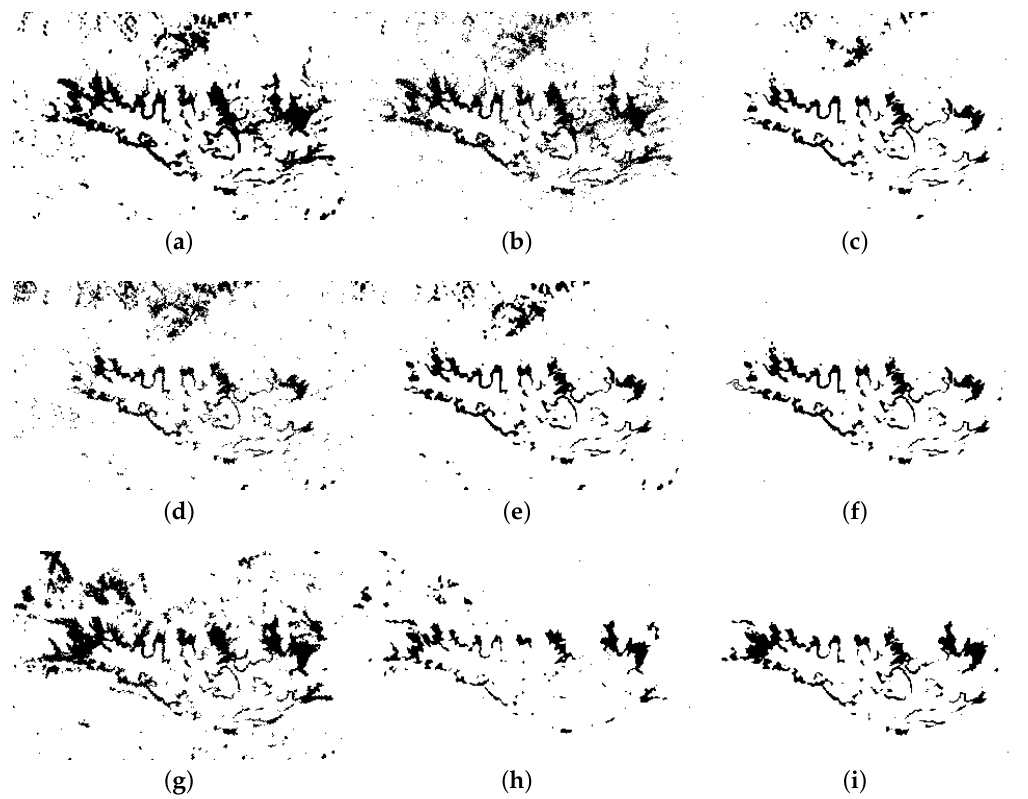
Figure 7. Change map of Malambuzha Dam, Kerala dataset (band 3) by ( a ) FCM on Normalized DI, ( b ) FCM on Ratio Image, and ( c ) FCM on bandwise NSCT fusion ( d ) Bandwise NSCT fusion +SPSO ( e ) Bandwise NSCT fusion +PSOLF ( f ) Bandwise NSCT fusion +LIPSO ( g ) CVA+LIPSO ( h ) Transform CVA+LIPSO ( i ) Proposed NSCT feature fusion fusion(All 4 bands)